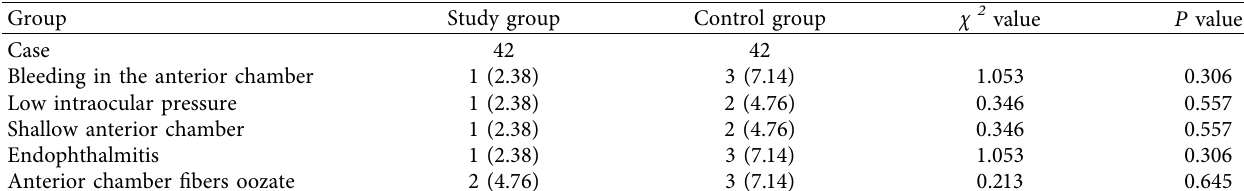
Table 4: Comparison of complications between the two groups n (%).